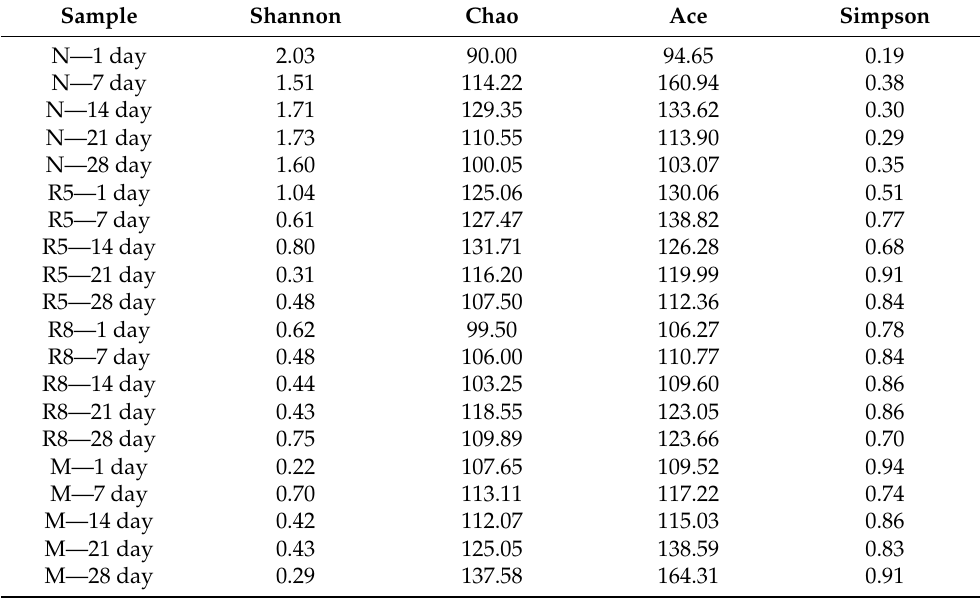
Table A1. The bacterial α -diversity index of pickles during